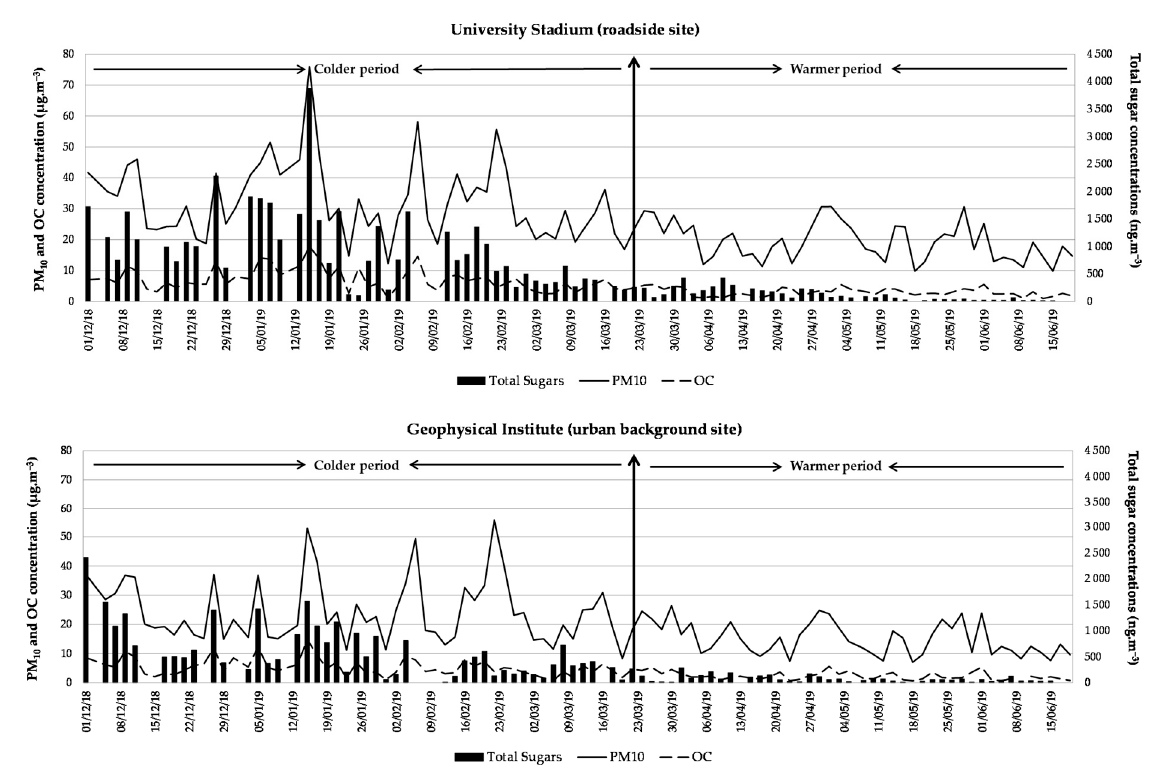
Figure 1. Particulate matter <10 µ m (PM 10 ), organic carbon (OC) and total sugar concentrations measured during the sampling campaign for each sampling site. Table 3. PM 10 and OC seasonal mean concentration ( µ g · m − 3 ) for each sampling